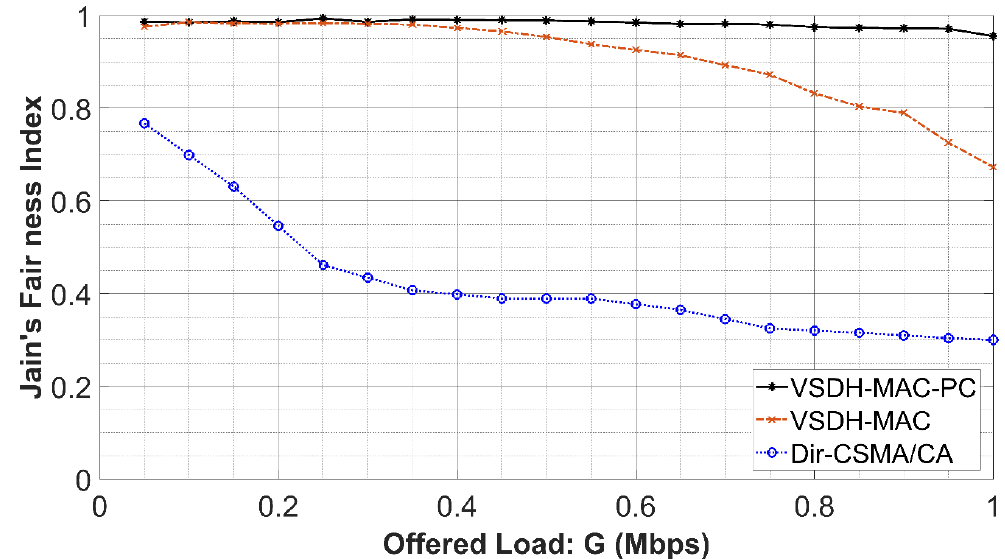
Figure 11. Jain’s fairness index improvements with the power control mechanism applied compared to VSDH-MAC with no power control and the modified directional CSMA/CA in a network with 50 nodes.